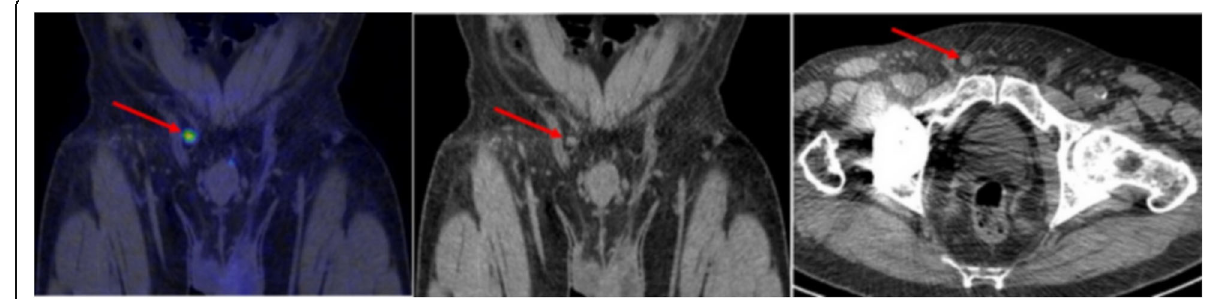
Fig. 2 The only case of discordant miM classification was a case of a patient with a vas deferens lesion considered as visceral metastasis by two observers and as inguinal lymph node for the other